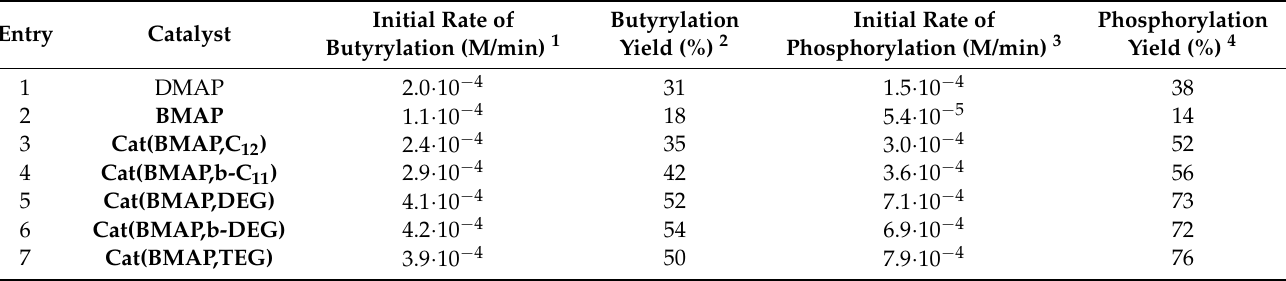
Table 2. Butyrylation and phosphorylation of substrate 4 , promoted by the catalysts of the BMAP family, as depicted in Scheme